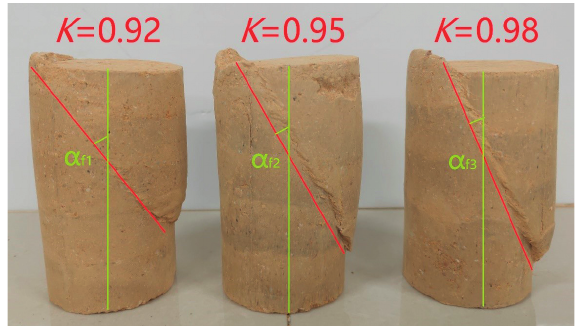
Figure 11: Angle between the failure surface and major principal stress direction ( n � 0, σ